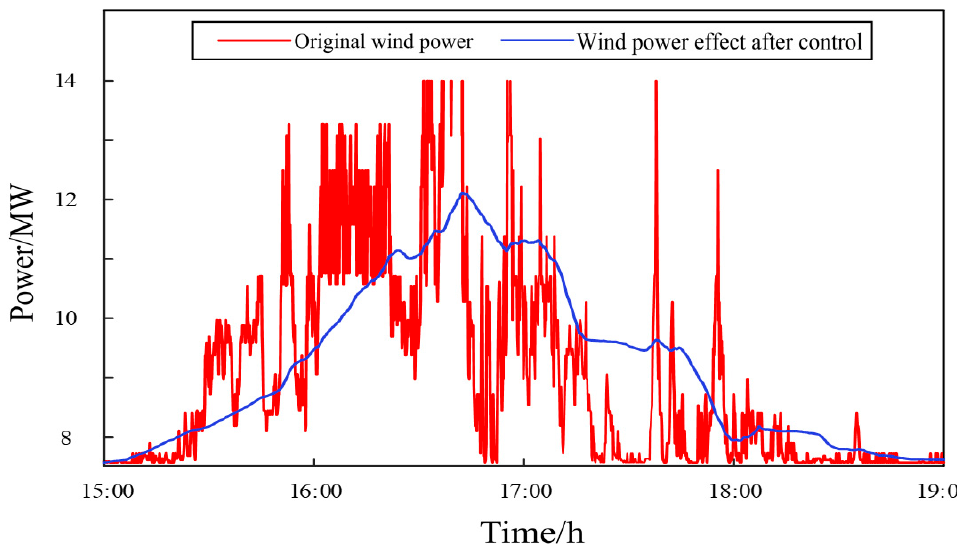
Figure 13. Wind power stabilization effect after stratified control. Table 2. Comparison of stabilization effect index.